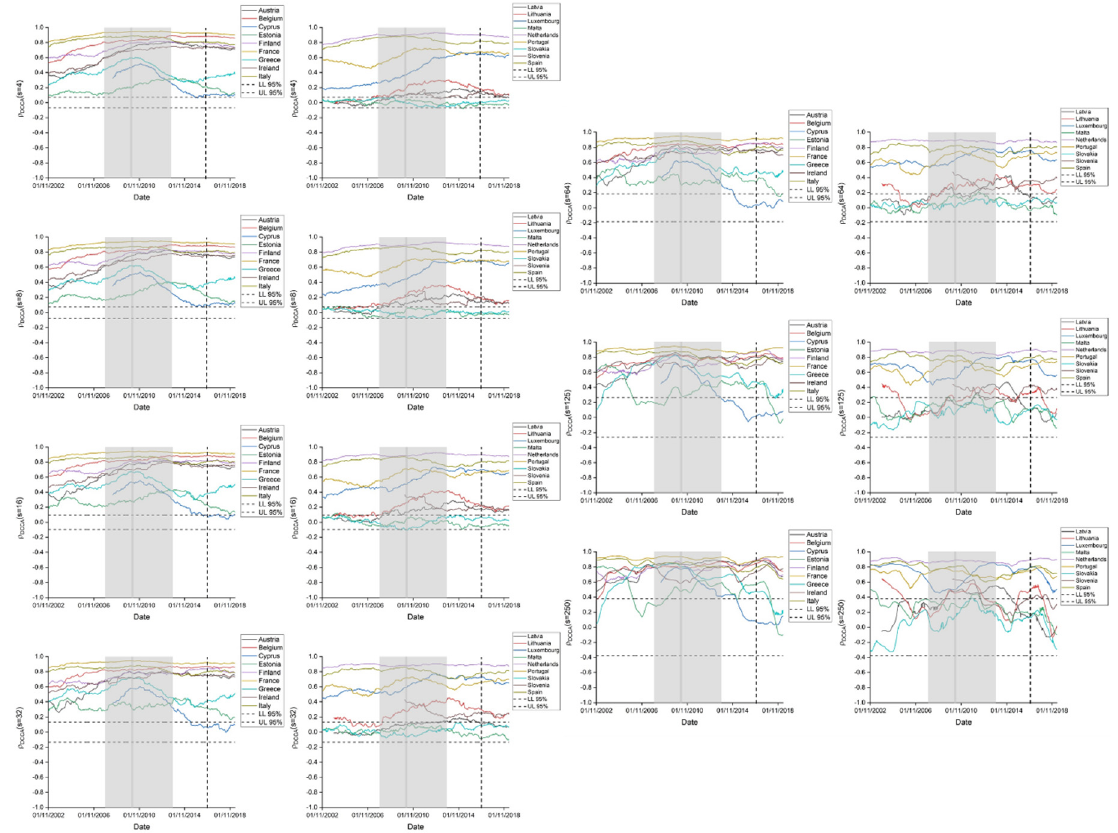
Figure A1. Evolution of ρ DCCA between Eurozone stock markets and Germany (time scales of 4, 8, 16, 32, 64, 125, and 250 days with a window size w = 1000). LL and UL are, respectively, the lower and upper limits of the confidence interval. Shaded areas represent the global financial crisis and the Eurozone debt crisis. The vertical dashed line refers to the moment of the Brexit referendum.